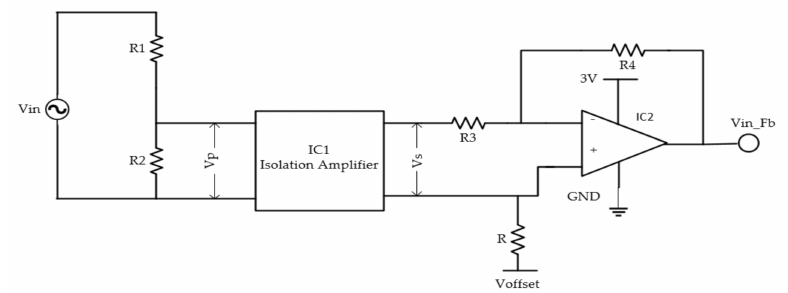
Figure 21. Block diagram of the designed isolated AC voltage sensor (V.S 1).